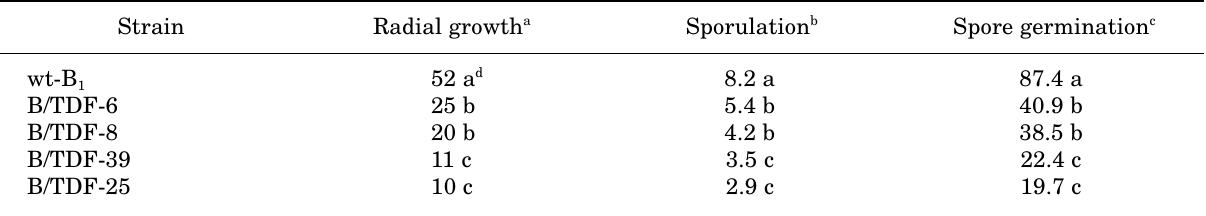
) in respect of some saprophytic fitness parameters on agar 1